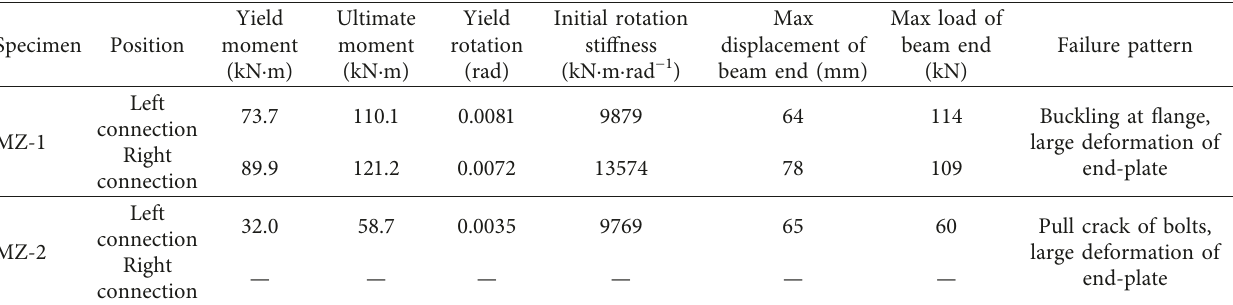
Figure 2: Test setup and the material test. (a) Joint of the interior column loaded. (b) Testing rig. (c) Material test samples. (d) Necking area. Table 4: Test